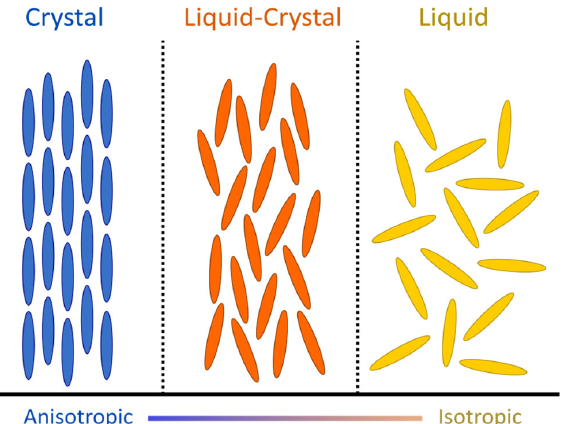
Figure 1. Illustration of the thee states of matter of rod-shaped objects (e.g., myocardial cells and/or myosin molecules). Between the crystal and liquid phase, the liquid-crystal phase is a mesophase sharing some of the properties of the two states of matter, where the molecules will arrange themselves due to their mutual interactions, with a certain degree of order, either positional or orientational while maintaining mobility.